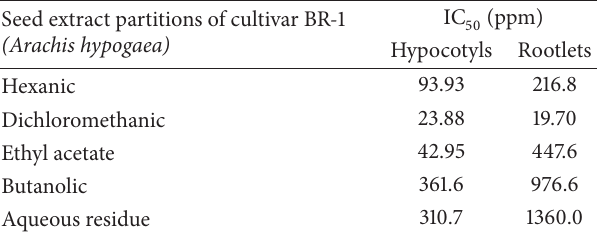
The same letter means no statistically significant difference between the samples. Table 5: IC 50 of partitions of seed ethanolic extract of cultivar BR-1 of A . hypogaea on the inhibition of L . sativa growth of hypocotyls and rootlets.